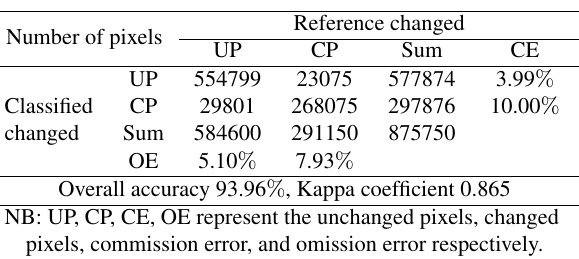
Table 4: Changed/unchanged confusion matrix for the sub-area in Algeria.